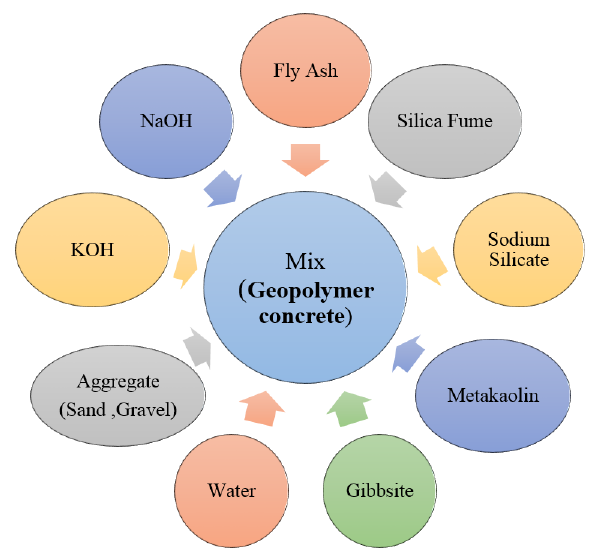
Figure 4. Schematic representation of the ingredients of geopolymer concrete. The production stages from cradle to gate of the OPC concrete and the AAB con- crete [19] are represented in Figures 5 and 6, respectively. The process of producing